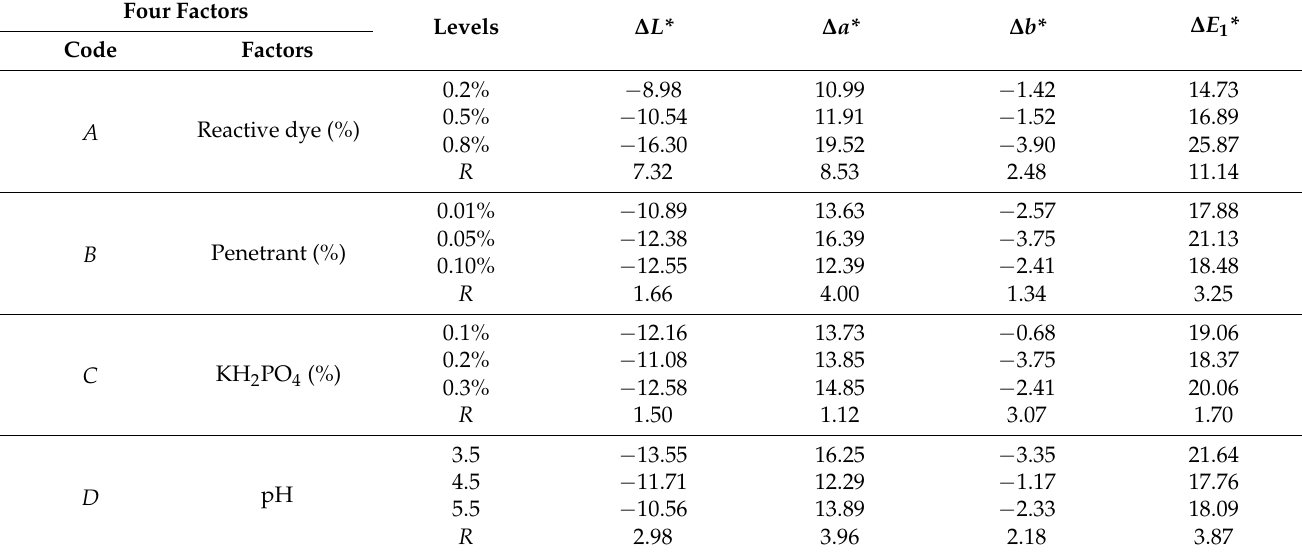
Table 3. Range analysis of the color difference indexes of dyed red-heart Chinese fir wood. Four Factors